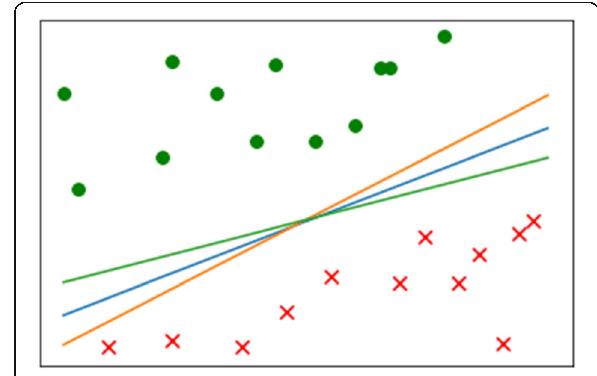
Fig. 3 Shows the principle of best hyperplanes selection. In two- dimensional space, the training data (green circle and red X) can be separated by many hyperplanes, so selection is an important process for the classifier. That is the principle of parameters optimization of